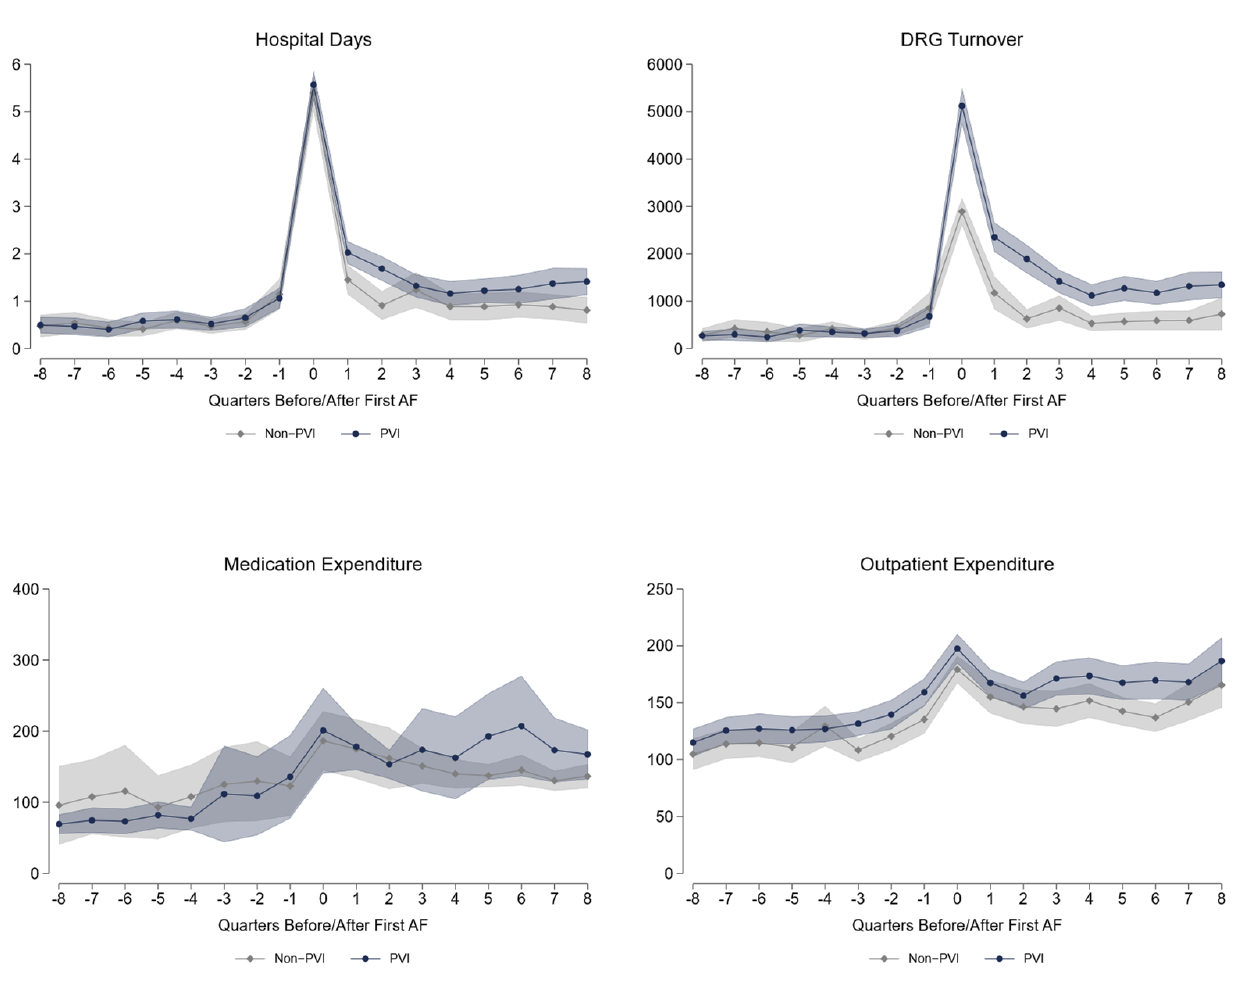
Figure 1. Short-term healthcare Expenditure and Hospital days. Long-term data up to 10 years after fhfAF reveal a significantly higher health care utilization in the PVI treatment strategy group with respect to hospital days, inpatient Table 2. Short-term Outcomes eight quarters after first hospitalization for atrial fibrillation. expenditures (diagnosis-related groups (DRG) turnover is the actual accounting calculated from the DRG points), and outpatient medical attendance Figure 2. As can be seen from Ø Non – PVI Table 3, PVI patients roughly spend € 2200 more per year than non-PVI patients, with most difference in inpatient costs. Their need for pacemaker implantation is significantly higher (+2.5pp) and the same holds true for cardioversion (+19pp). More coronary artery disease and hyperlipidemia with a trend to lower heart failure diagnosis is seen in PVI, whereas the probability of peripheral artery disease is higher in non-PVI patients. Significantly more AAD including betablockers, anticoagulants, and lipid-lowering drugs are prescribed in the PVI based treatment group with a higher prescription rate of antidiabetic drugs in the non-PVI group. Regarding labor market outcomes, we demonstrate a significantly higher employment rate (+5.1pp), due to reduced retirements ( − 7.6pp). On the contrary, sick leave days are roughly 3 days more per year for PVI patients. Of highest importance, all-cause mortality shows a 5.8pp reduction over 10 years in the PVI based treatment strategy. The largest share of this difference arises in the first 5 years Figure 3. Modes of death were not different in both groups, as can be seen by the absolute numbers presented in Table